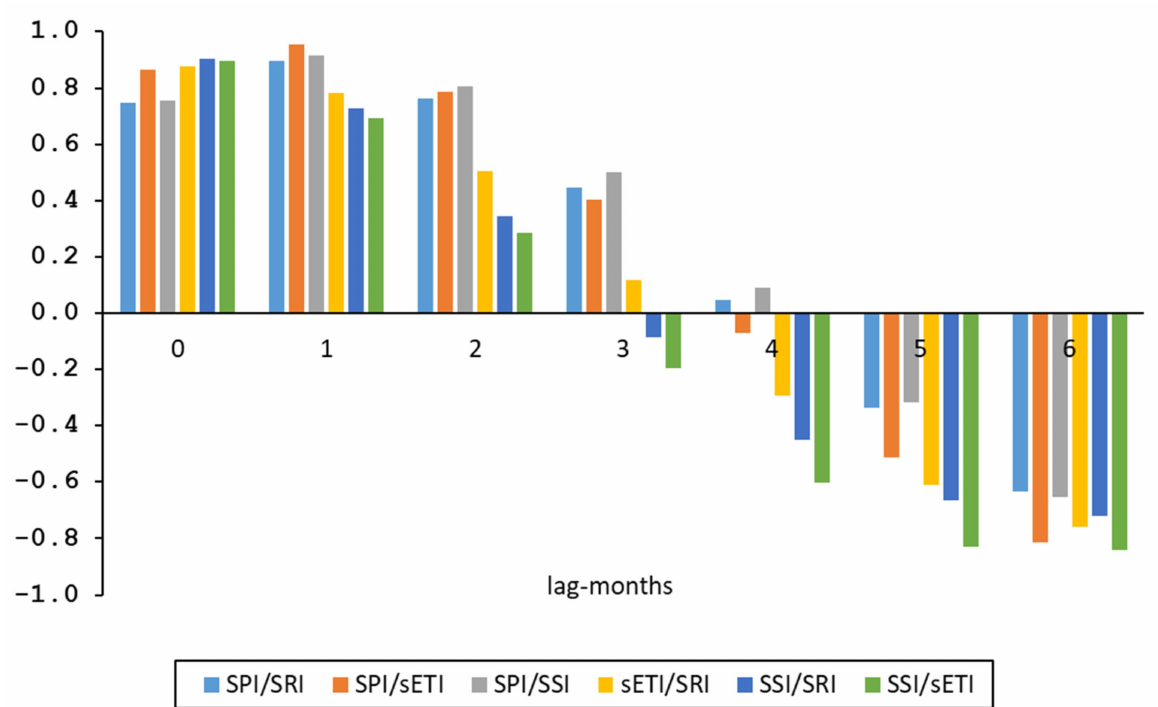
Figure 13. Correlation results among monthly indices with a time lag up to 6